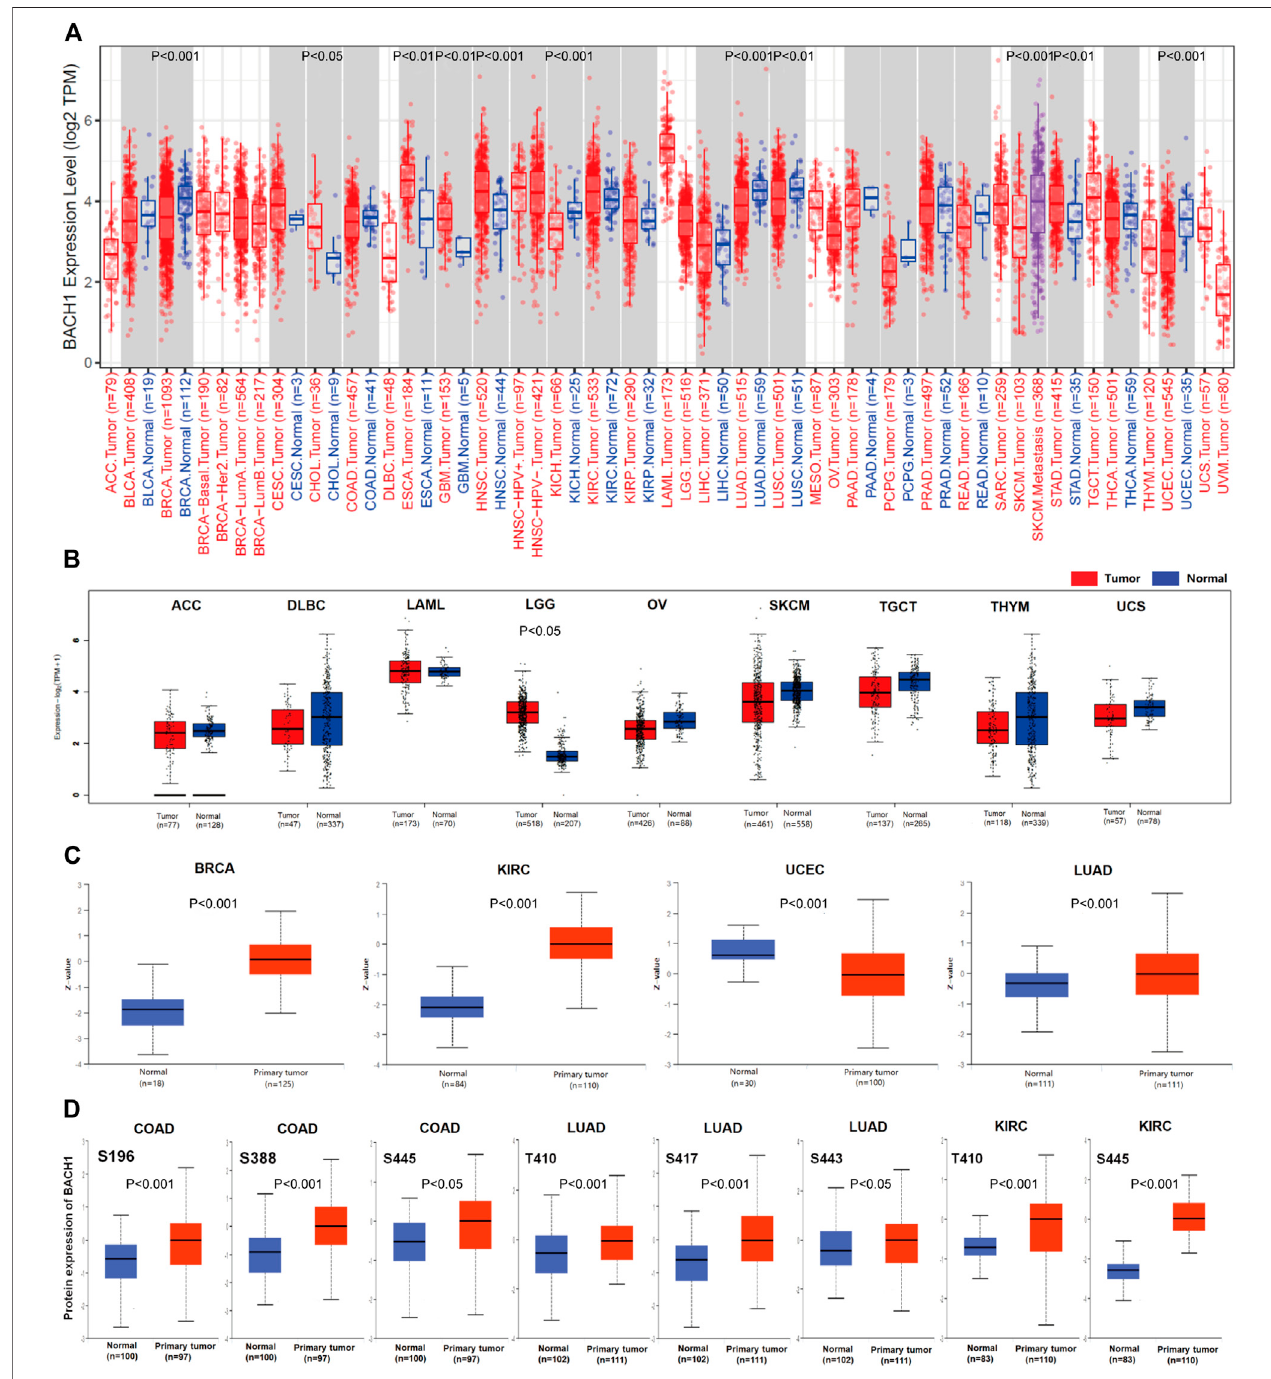
FIGURE 1 | Pan-cancer expression landscape of BACH1. (A) The expression of BACH1 in 33 cancer tissues from the TCGA database (B) The expression of BACH1inGTExandTCGAdatabase. (C) TheexpressionlevelofBACH1inprimarycancerandnormaltissueintheCPTACdatabase (D) TheexpressionlevelofBACH1 phosphosites in different cancer